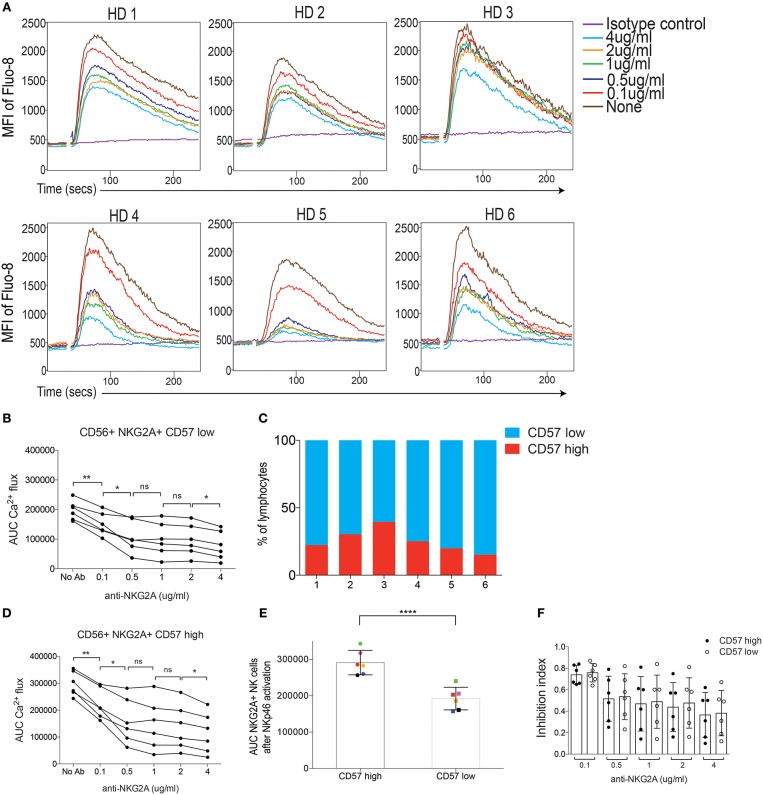
Crosslinking of NKG2A dampens Ca2+ flux triggered by NKp46 stimulation in human 6 human donors. (A) Kinetics plot of Fluo-8 fluorescence of CD57 low, CD56+, NKG2A+ NK cells stained with biotinylated anti-NKp46 and biotinylated anti-CD94 and co-crosslinked using by Streptavidin. HD1-HD6 depict the 6 donors. Different concentrations of anti-NKG2A are color-coded. (B,D) Total AUC values of CD56+ NKG2A+ CD57 low NK cells, after baseline correction, of the data in (A). Statistics were calculated using a paired Student's T-test for the combinations indicated. (C) The fractions of CD57high/CD57low NK cells from HD1-HD6. Gating as indicaed in Figure S2. (D) Similar data as in (B) but for CD56+ NKG2A+ CD57 high NK cells. (E) Total AUC values of CD57 high and CD57 low NK cells stimulated with biotinylated anti-NKp46 and crosslinked with Streptavidin, in the absence of inhibitory receptor crosslinking. Statistics were calculated using a parid Student's T-test. (F) The inhibition index obtained by streptavidin-mediated crosslinking of NKG2A+ NK cells at lowering concentration of biotinylated anti-CD94, and comparing CD57 low and CD57 high NK cells. No significant differences were seen. *p < 0.05, **p < 0.01, ****p < 0.0001, ns, not significant.